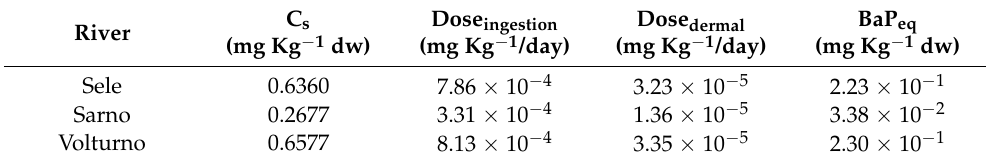
Table 7. Average total PAH concentrations (C s ), intakes by accidental ingestion (Dose ingestion ), and dermal contact (Dose dermal ) of PAH present in estuarine sediments of the Sele, Volturno, and Sarno Rivers and equivalent toxic concentrations (BaP eq ).